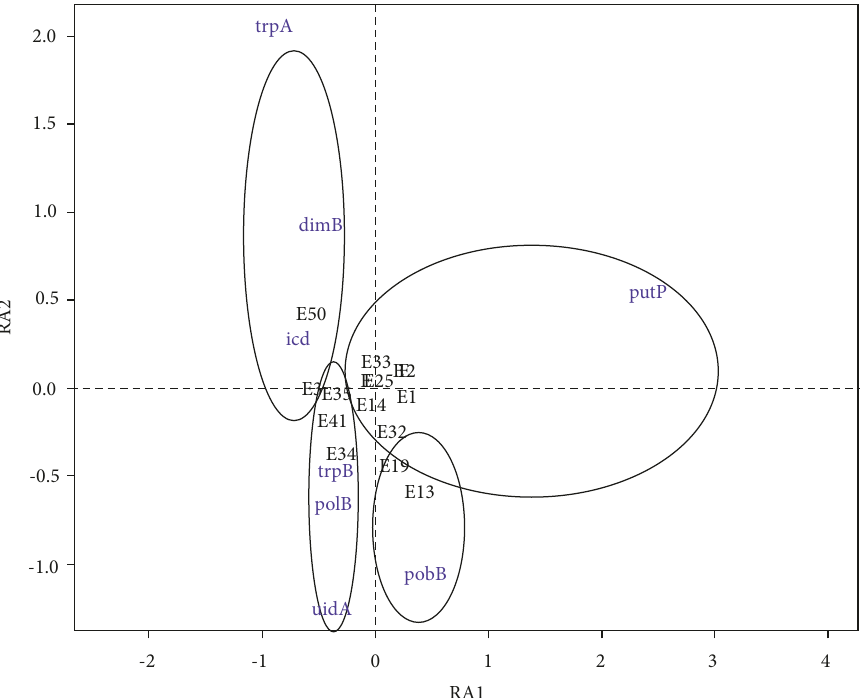
Figure 4: Projection on axes 1 and 2 of the DCA performed on the presence/absence data of 27 E. coli in 8